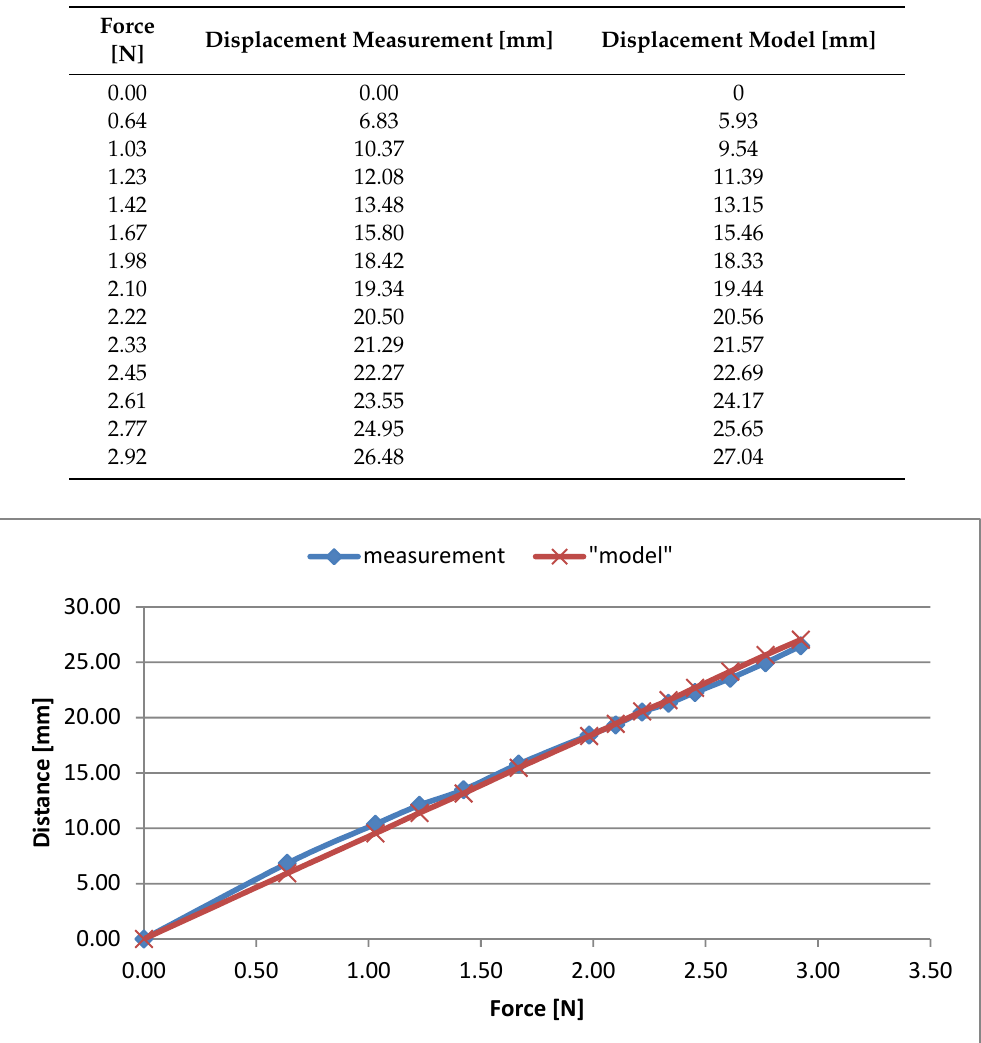
Figure 3. The finite element model (FEM) simulation of dielectric electro active polymer actuator for static force 1,42 [N]. Table 2. The comparison of the displacements for different load force.